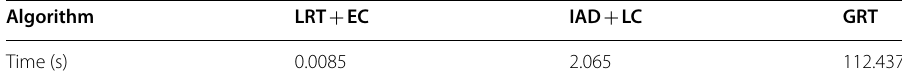
Table 1 The running time of algorithms Algorithm